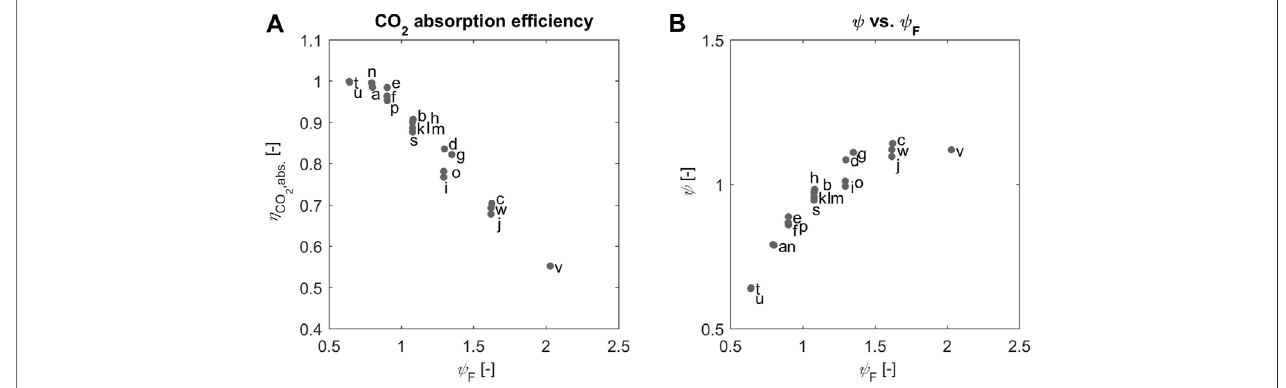
FIGURE 5 | (A) The absorption ef fi ciency and (B) the effective ratio of reactants is plotted over ψ F